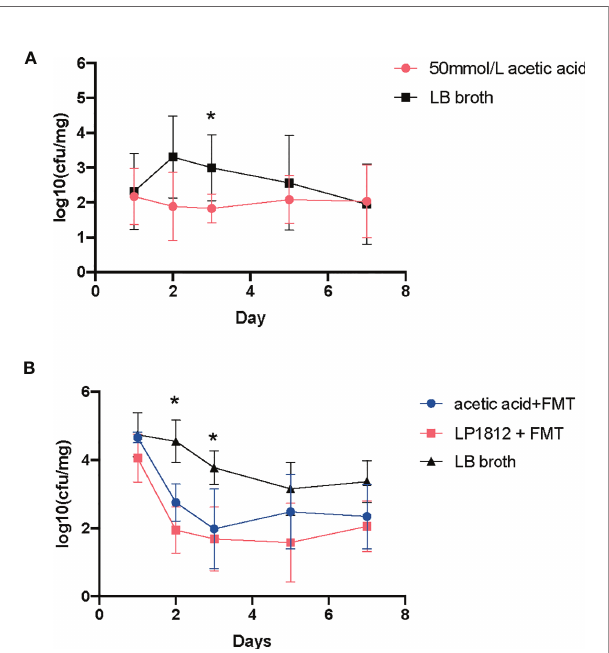
FIGURE 5 | The results of anti-CRKP assays. (A) The mice (n = 5) treated with LB broth containing 50 mmol/L acetic acid. (B) The mice treated with acetic acid + FMT (n = 5) or L. plantarum LP1812 +FMT (n = 5). *denotes the p-value <